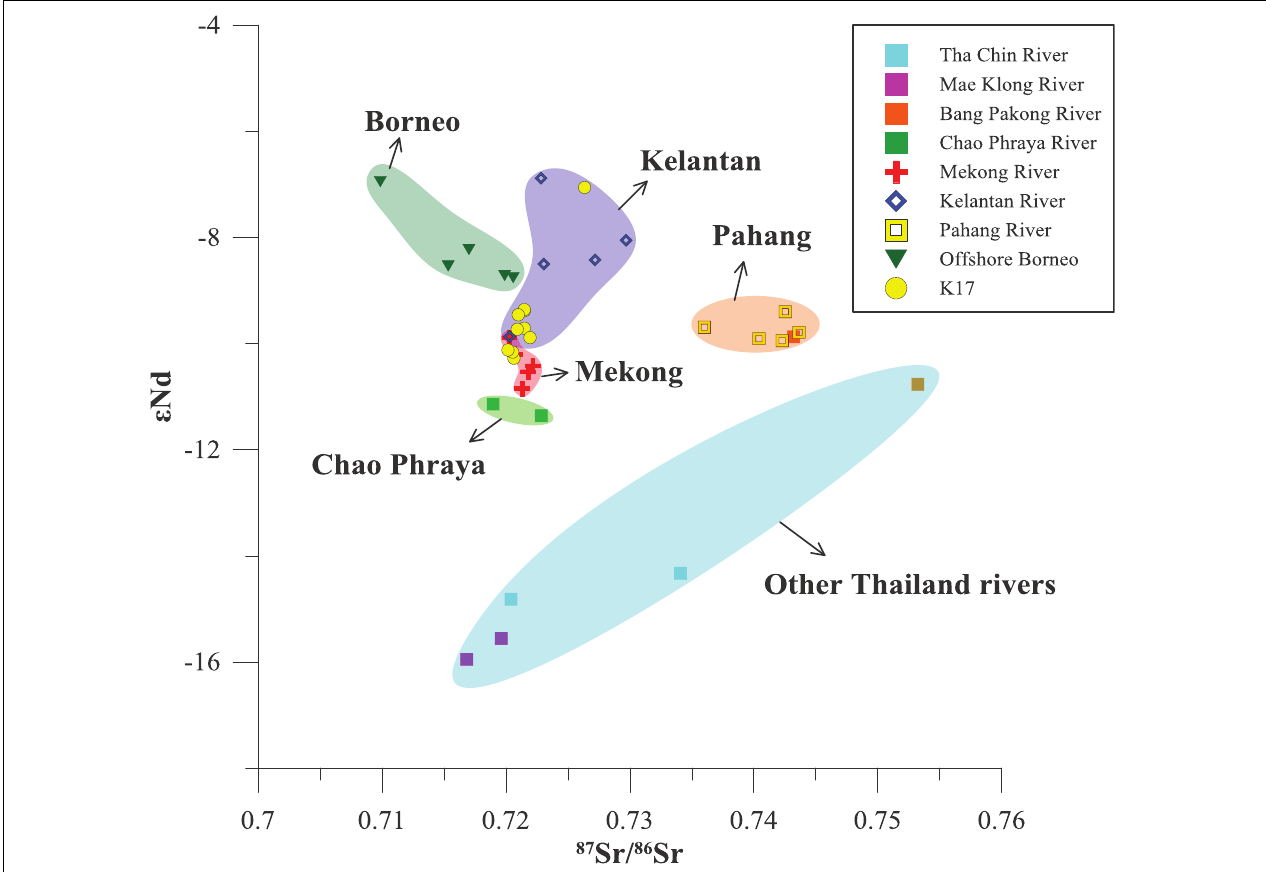
FIGURE 7 | The 87 Sr/ 86 Sr ratios versus ε Nd values plot for the Core K17, with sediments of Mekong River (Liu et al., 2007), Borneo offshore (Wei et al., 2012), Chao Phraya River and other Thailand rivers (Wu et al., unpublished), and Pahang and Kelantan River (this